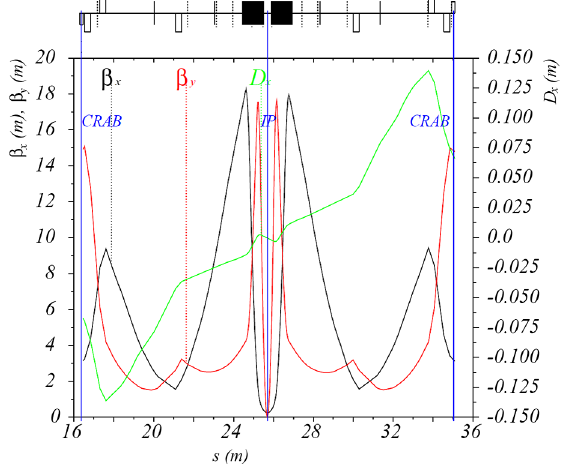
FIG. 3. Optical functions of DA Φ NE interaction region with crab waist sextupoles.